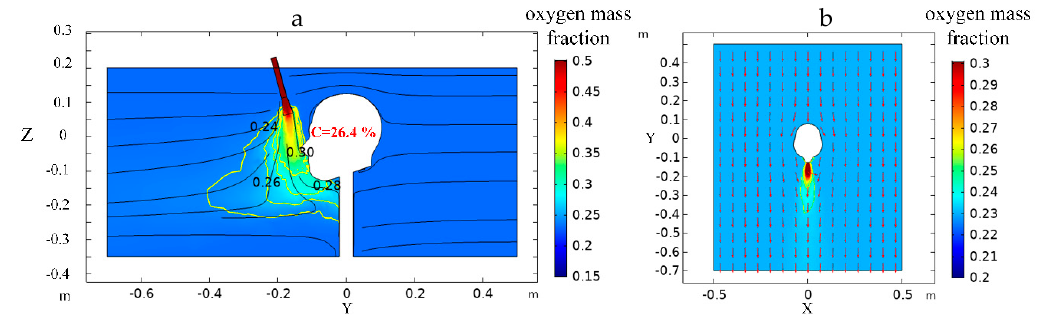
Figure 7. ( a ) Side view of oxygen mass fraction distribution at X = 0 m section. ( b ) Top view of oxygen mass fraction distribution at Z = 0.05 m section.